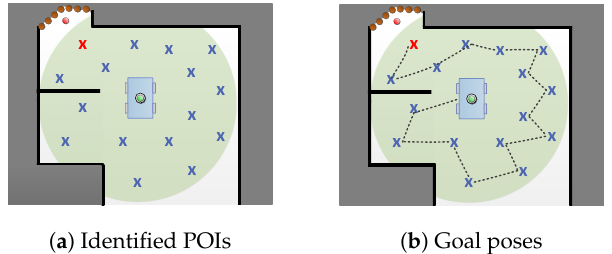
Figure 3. Main components of our exploration strategy. ( a ) Current position x [ t ] is marked with a green circle, light red cross marks goal location x G within planning radius r (shaded green area), blue crosses represent POI , while orange circles are frontier with its centroid x f (red circle); ( b ) optimized by X poi distance travelled, are represented as ordered points, i.e., goal poses X goal , which describe the X poi sequence that the robot follows, obtaining measurement z [ g ] on each x [ g ]